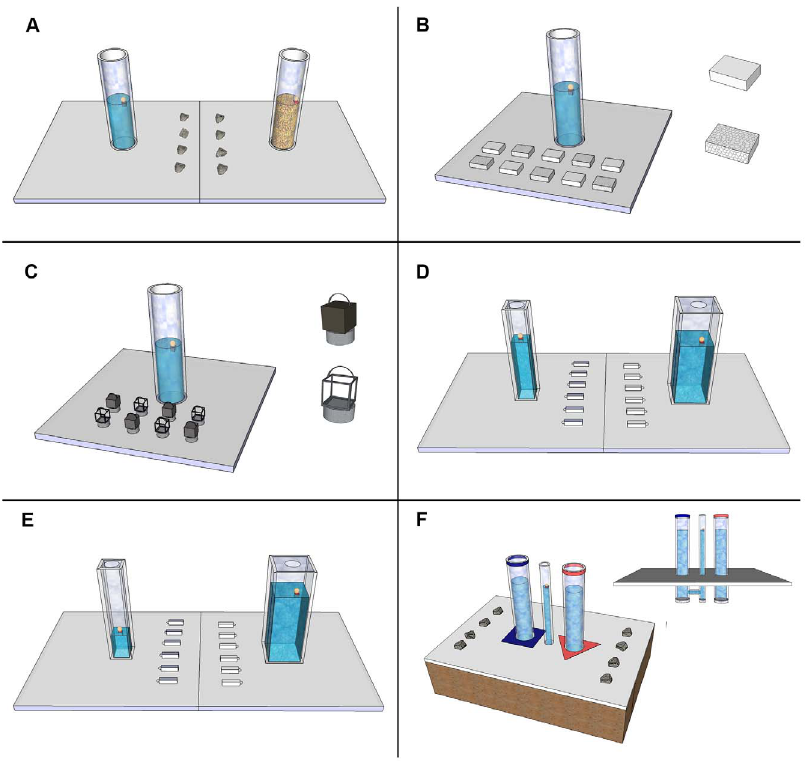
Figure 1. Diagrams of the apparatus used in each of the 6 experiments. In each experiment birds dropped objects into tubes to obtain an out of reach food reward. Each experiment involved either a choice of two tubes or a choice of two objects. The apparatus was presented on a table in the centre of a large testing cage, as pictured. A: Experiment 1, Sand-filled tubes v Water-filled tubes, B: Experiment 2, Sinking v Floating objects, C: Experiment 3, Solid v Hollow objects, D: Experiment 4, Narrow v Wide tubes, E: Experiment 5, High v Low water levels in Narrow and Wide tubes, F: Experiment 6, U-tube, a concealed connection links one of the outer tubes with the rewarded central tube.